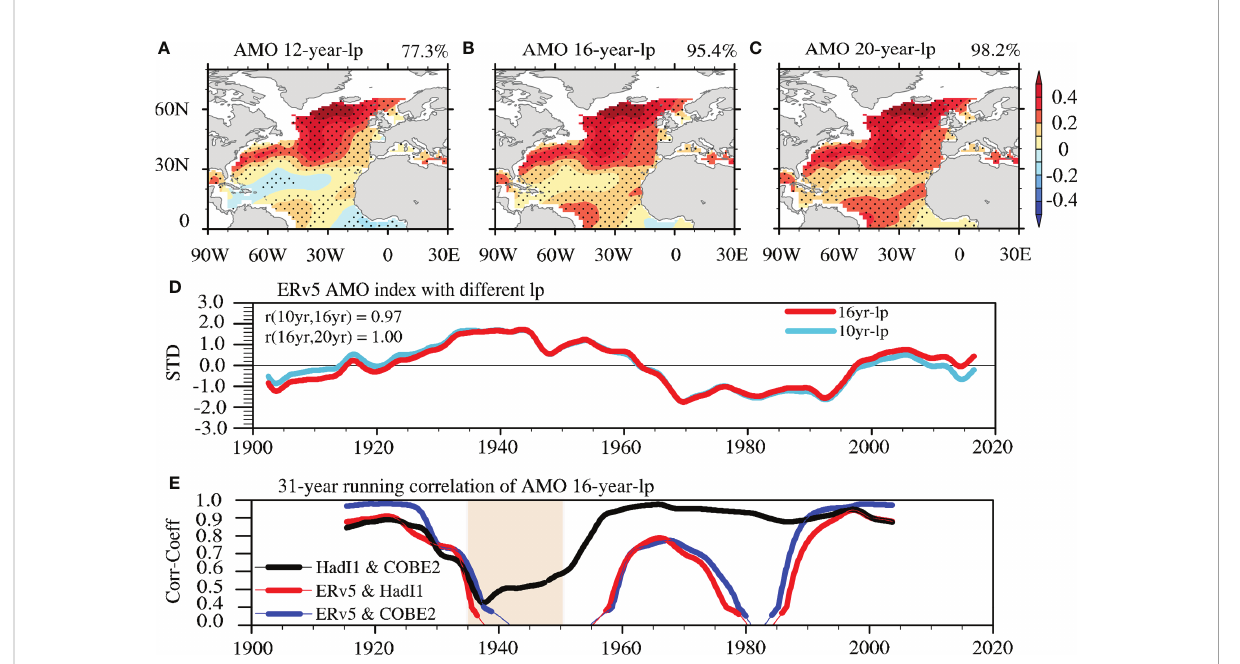
FIGURE 7 The AMO pattern extracted by LFCA from ERv5 with three low-pass fi lter frequencies: (A) 12 years, (B) 16 years, and (C) 20 years in LFCA (40 EOFs are also applied). Dots indicate where values pass the 95% signi fi cance level, and the AMO CI is denoted in the top right. (D) AMO indices with different low-pass fi lter frequencies, and their TCCs are given. (E) Similar to Figure 2C but the AMO is extracted using a 16-year low-pass fi lter. The unit in (A – C) is